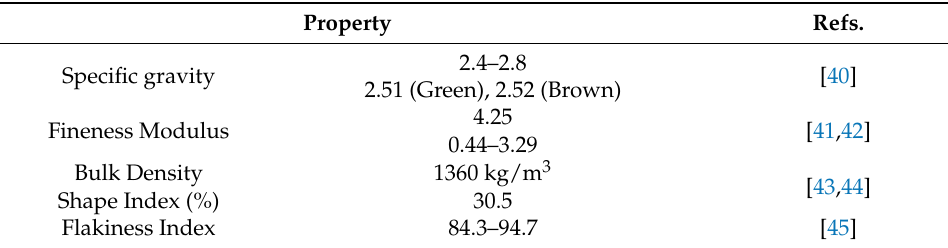
Table 3. Physical properties of crushed WG.